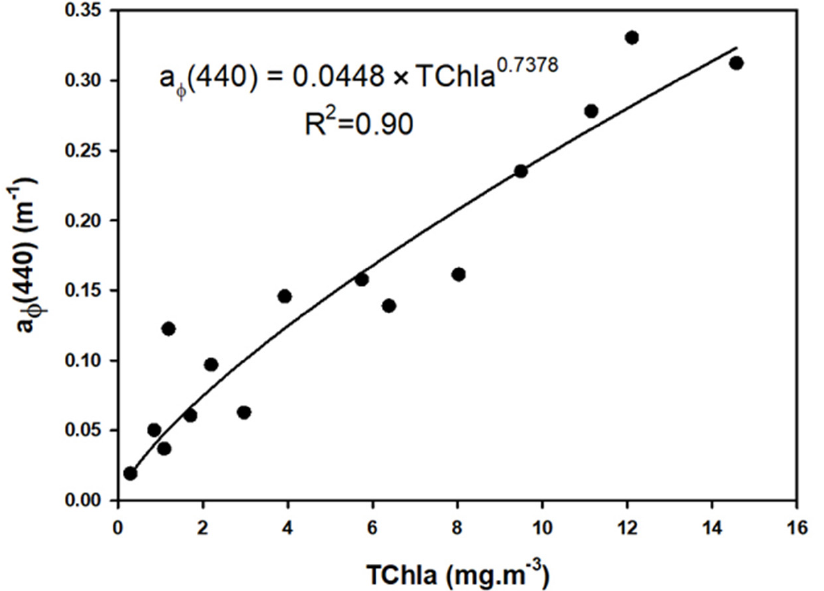
Figure 9. Relationship between phytoplankton absorption coefficient at 440 nm (a φ (440)) and TChl a across Princess Charlotte Bay.